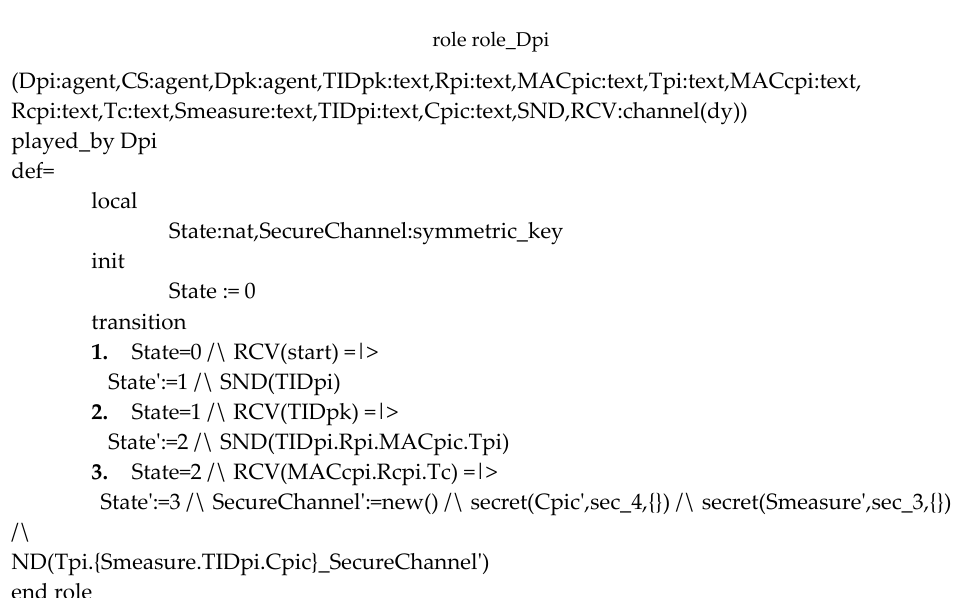
Figure 10. Role of D2D device Dpi in PUP phase.